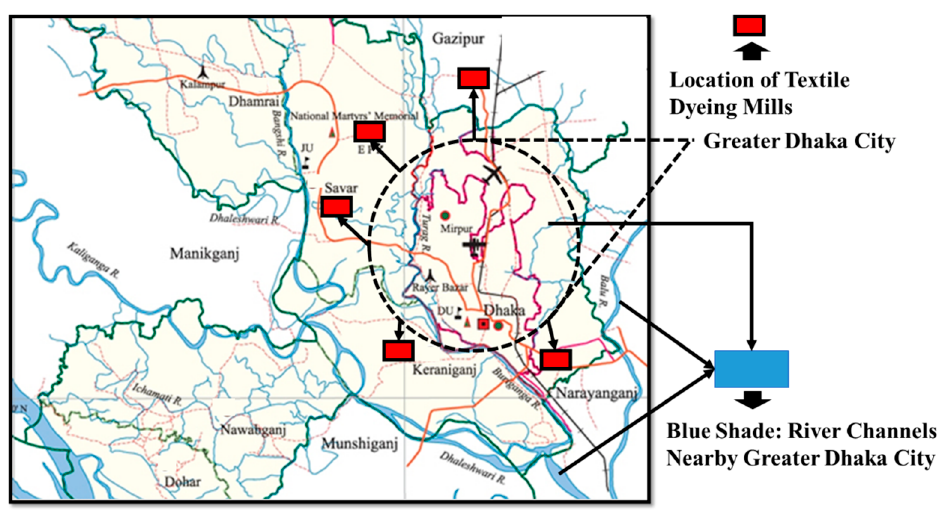
Figure 1. River water pollution by industrial waste in adjacent rivers of Dhaka city. Adapted from [28].